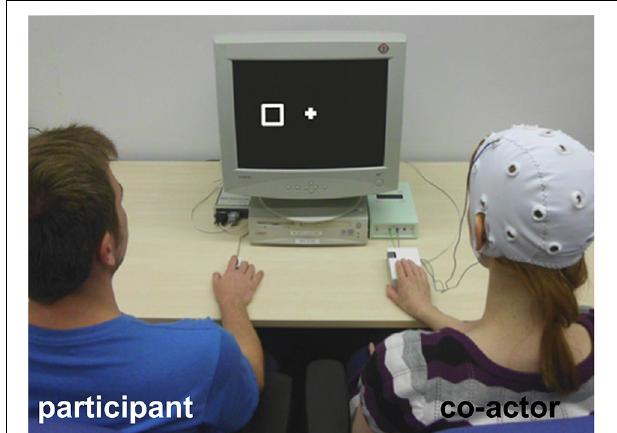
FIGURE 3 | Experimental setup used in Experiment 2. The participant (left side) shared a joint go/nogo Simon task with a co-actor (confederate, right side) wearing an EEG cap with electrodes attached to the motor cortex, and placing the finger underneath the moving part of a response device. The participant was either told that the confederate intentionally controlled the response button via a BCI so that the causal relationship between co-actor and action effect was not perceivable (agency − /intentionality + condition) or that the response button was controlled by the computer (agency − /intentionality − condition). As the same response button was used for the co-actor in the agency − /intentionality + and the agency − /intentionality − condition, the setup shown on the picture applies to both conditions.